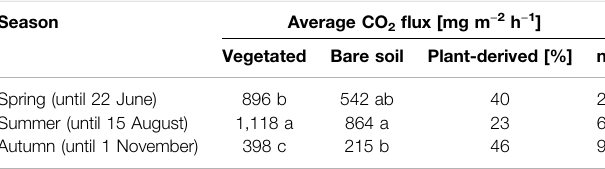
n (cid:1) number of data points. Different letters after values indicate signi fi cant differences between seasons, based on analysis of variance (ANOVA) and Honest Signi fi cance Difference